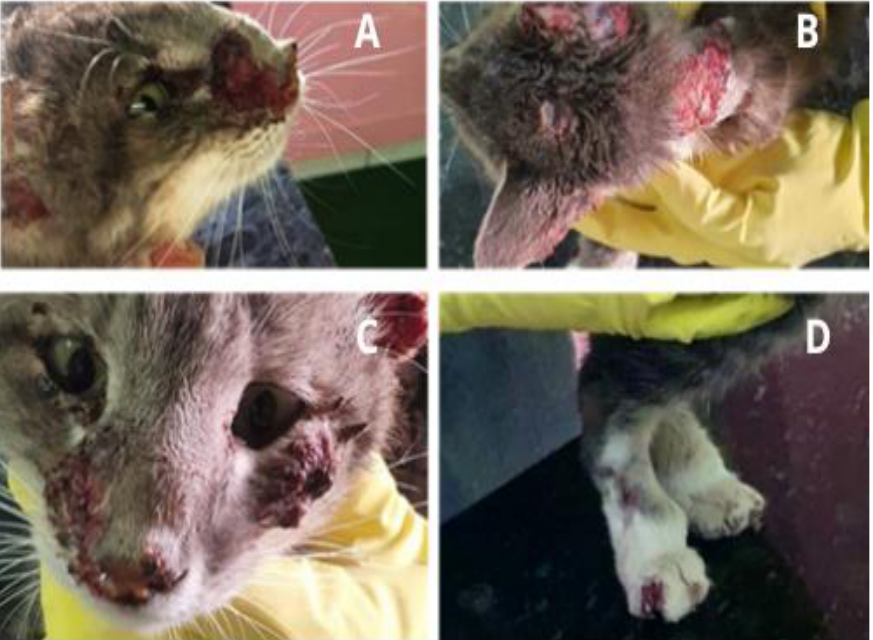
Figure 3. Clinical aspects of cutaneous sporotrichosis in cats. ( A ) Nasal region with crusted skin lesions on the nasal bridge. ( B ) Multiple skin lesions on the back and ears. ( C ) Crusted lesions on the cat’s muzzle and face ( D ) Paronychia on the forelimb. Images provided by Sabrina Manzoli, Franca, SP, 2020.